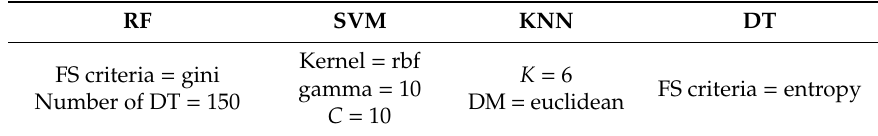
Figure 12. Accuracy distribution based on (a) damage category and (b) detection method. Table 4. Key parameters set in the comparison methods.